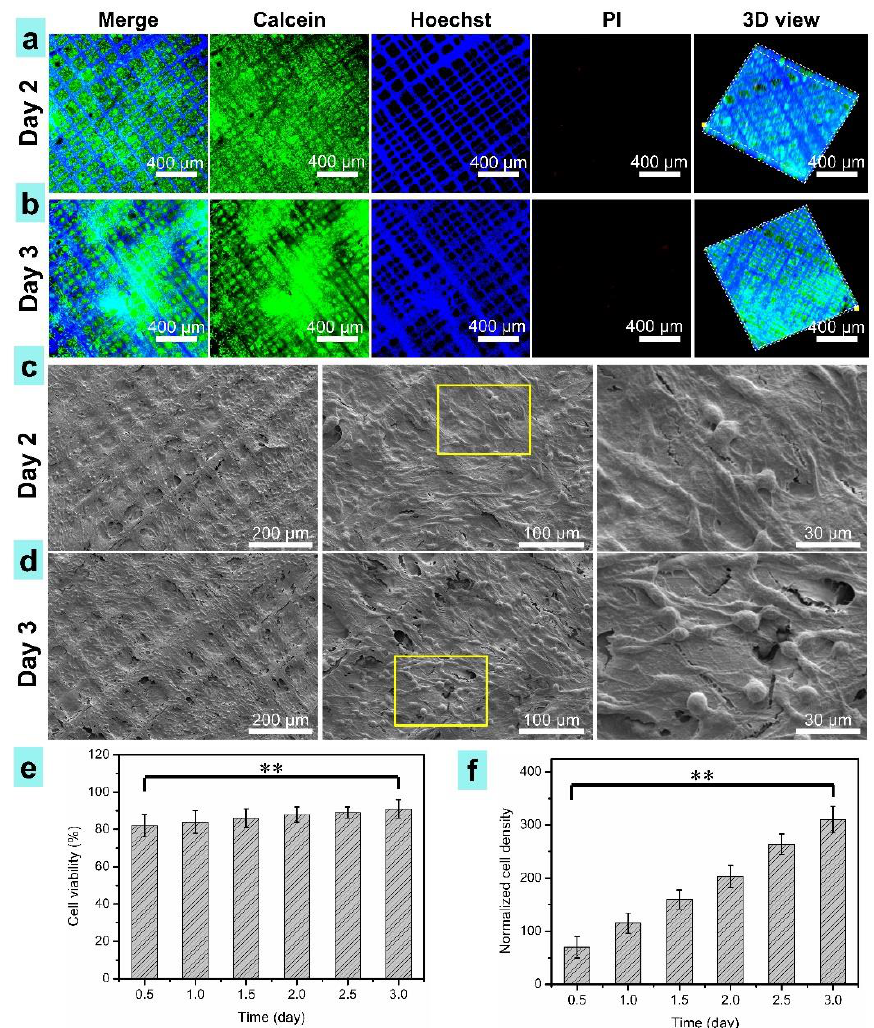
Figure 9. Characterization of cartilage cells on the printed PCL/PVP composite osteochondral scaffolds. ( a , b ) The LSCM fluorescent images, scale bars, 400 μm; ( c , d ) SEM observations of cell morphology; ( e ) Cell viability; ( f ) Normalized cells densities. ** indicate statistical significance of p < 0.01 ( n = 4).